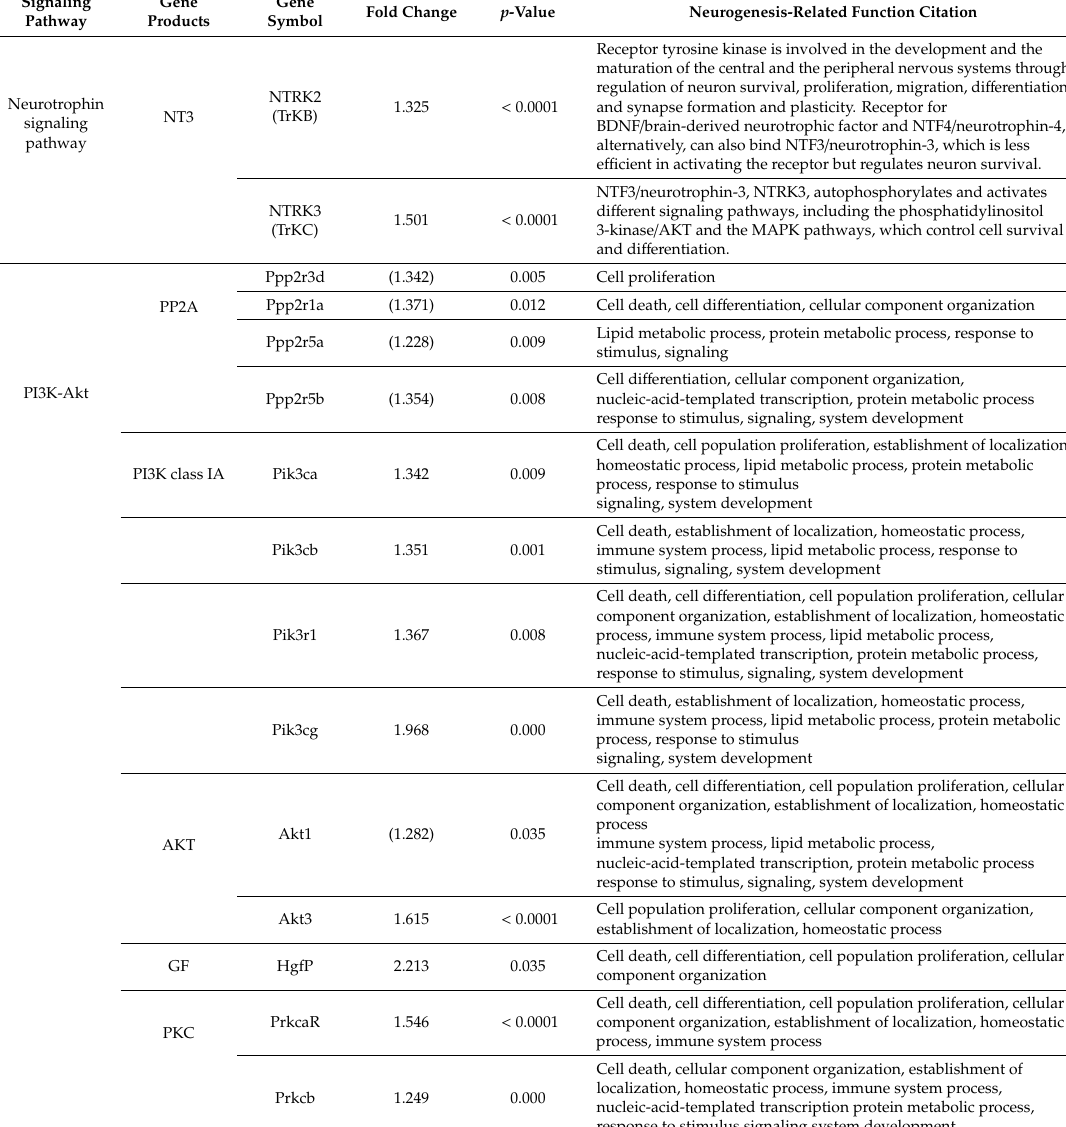
Table 1. BME treatment-induced changes in the expression levels of genes involved in neurogenesis-related signaling pathways in the hippocampus. The down-regulation of genes is indicated by the values in brackets. The function of each gene was identified by Genecards (https: // www.genecards.org) and / or Mouse Genome Databases (http: // www.informatics.jax.org). Signaling Gene Gene Pathway Products Symbol Fold Change p -Value Receptor tyrosine kinase is involved in the development and the maturationofthecentralandtheperipheralnervoussystemsthrough regulationof neuron survival, proliferation, migration, di ff erentiation, and synapse formation and plasticity. Receptor for BDNF / brain-derived neurotrophic factor and NTF4 / neurotrophin-4, alternatively, can also bind NTF3 / neurotrophin-3, which is less e ffi cient in activating the receptor but regulates neuron